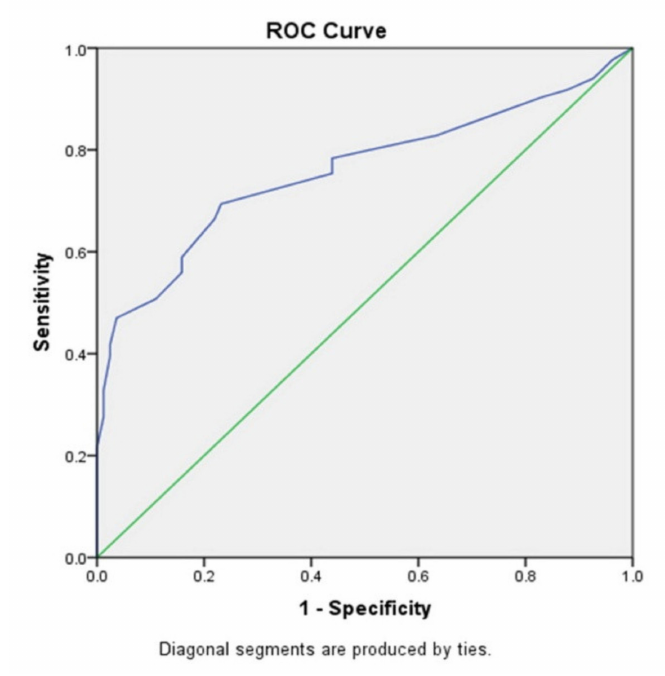
Figure 3. ROC curve of p16 expression in NIL and IBC.